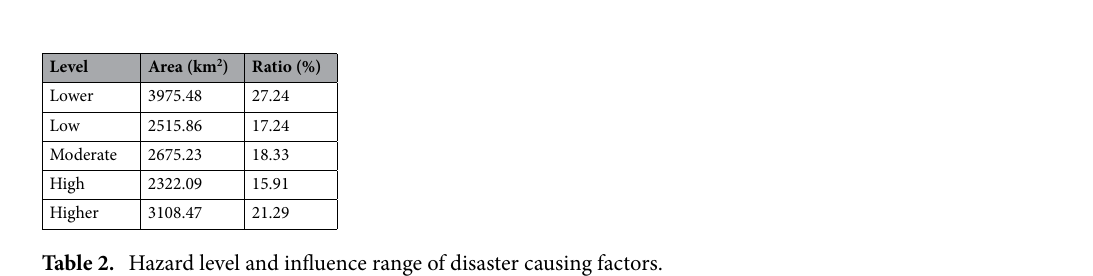
Table 2. Hazard level and influence range of disaster causing